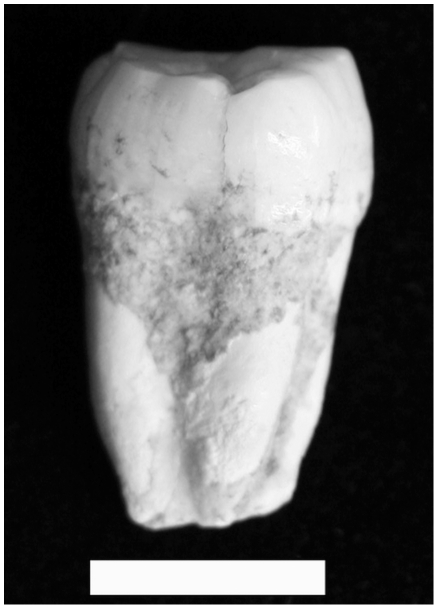
Isolated M3 – specimen MLDG 1747 (scale bar = 1 cm) exhibiting marked taurodontism.